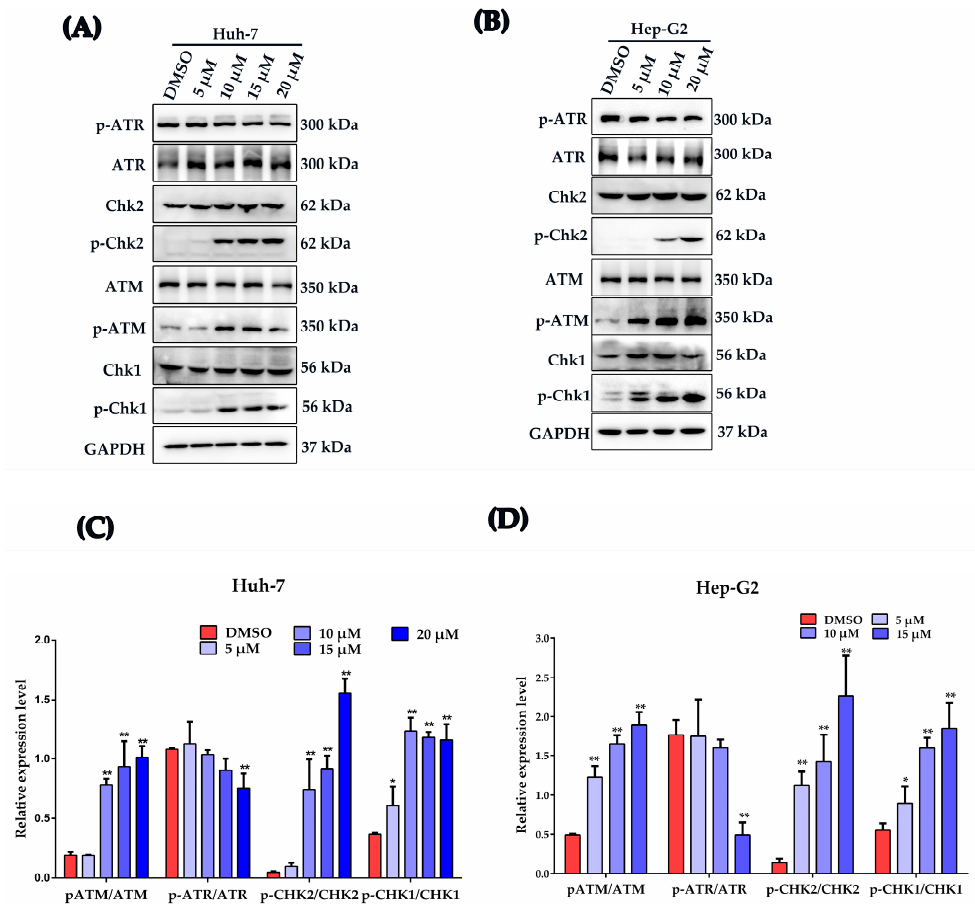
Figure 5. Plumbagin modulates the DNA damage response of HCC cells. ( A , B ) Huh-7 and Hep-G2 cells were dose-dependently treated by plumbagin and the expression of total ATM, p-ATM (Ser1981), total Chk2, p-Chk2 (Thr68), total ATR, p-ATR (Ser428), total Chk1 and p-Chk1 (Ser345) were analyzed by Western blot. ( C , D ) Gray value statistical analysis of the indicated proteins. * p < 0.05, ** p < 0.01 compared to the DMSO group; three independent experiments were performed.